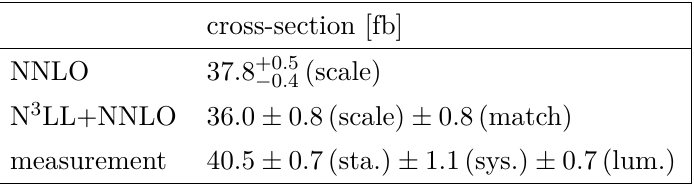
Table 3 . Comparison of total fiducial ZZ cross-section predictions at NNLO, N 3 LL+NNLO with the CMS analysis combining measurements from 2016, 2017 and 2018 [25]. Fiducial cuts are as in table 2.